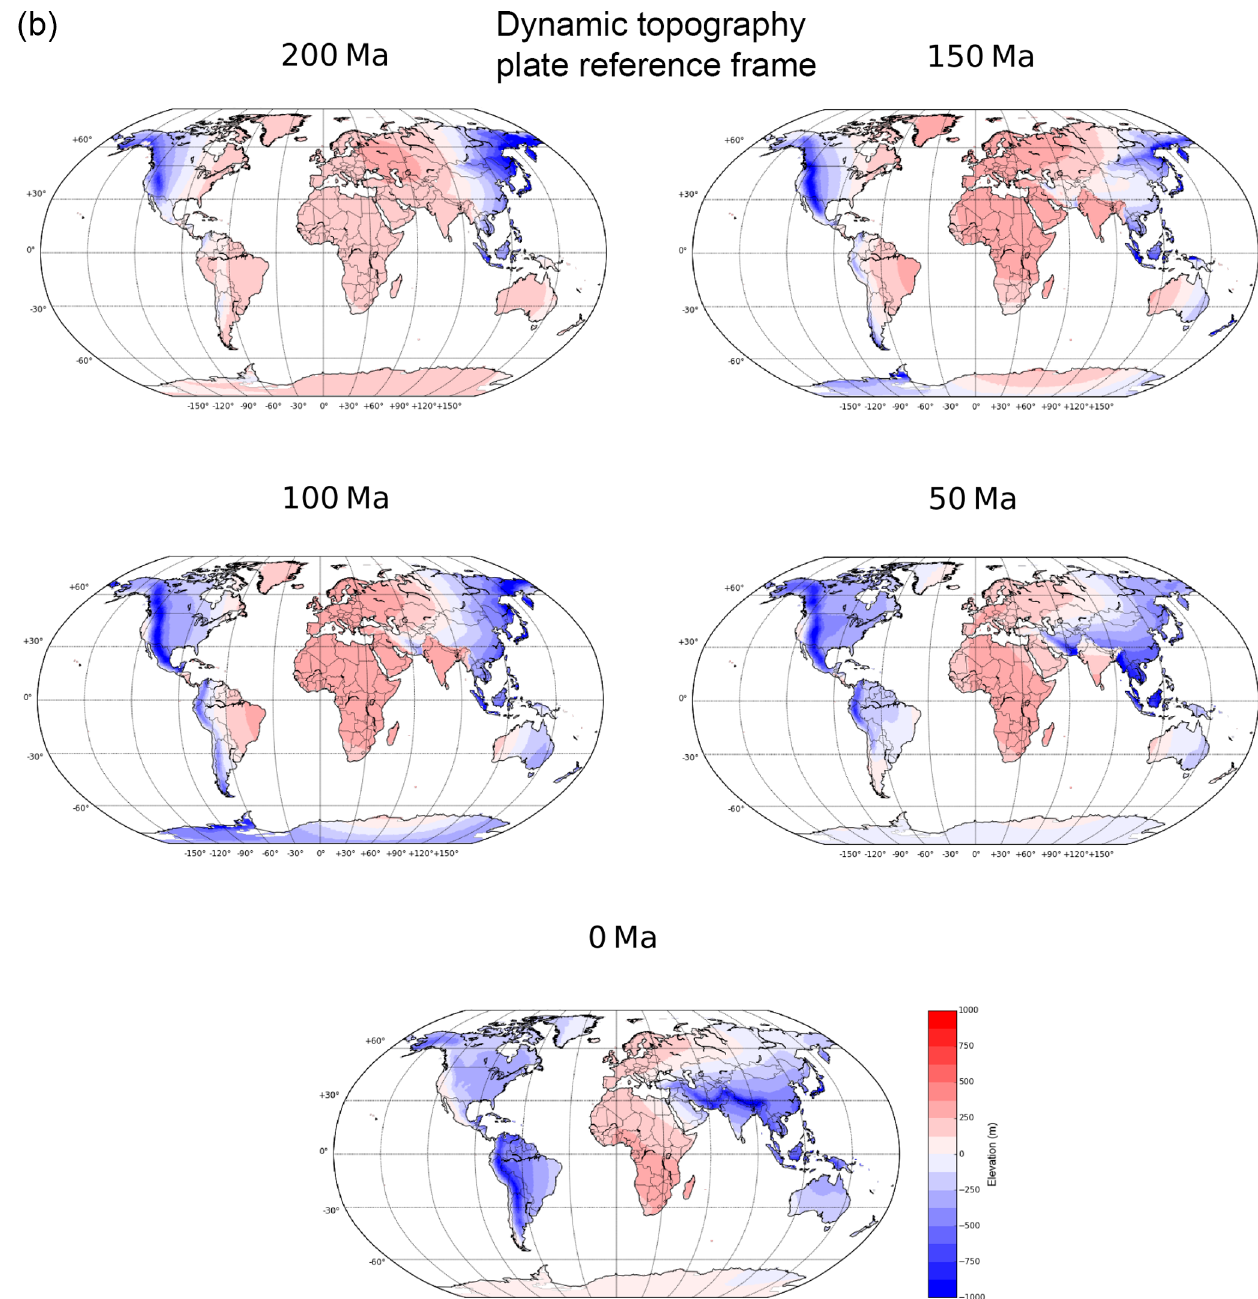
Figure 4. Evolution of global dynamic topographic elevation from 200Ma to present. Blue colours denote negative dynamic topography, and red colours mark positive dynamic topography. (a) Dynamic topography in the absolute reference frame. The indicated points show synthetic sample locations as discussed in the text. Note that sample points move along with their associated tectonic plates. The evolution of dynamic topography in 10Myr intervals can be found in the Supplement. (b) Dynamic topography in the plate frame of reference. The evolution of dynamic topography in 10Myr intervals can be found in the